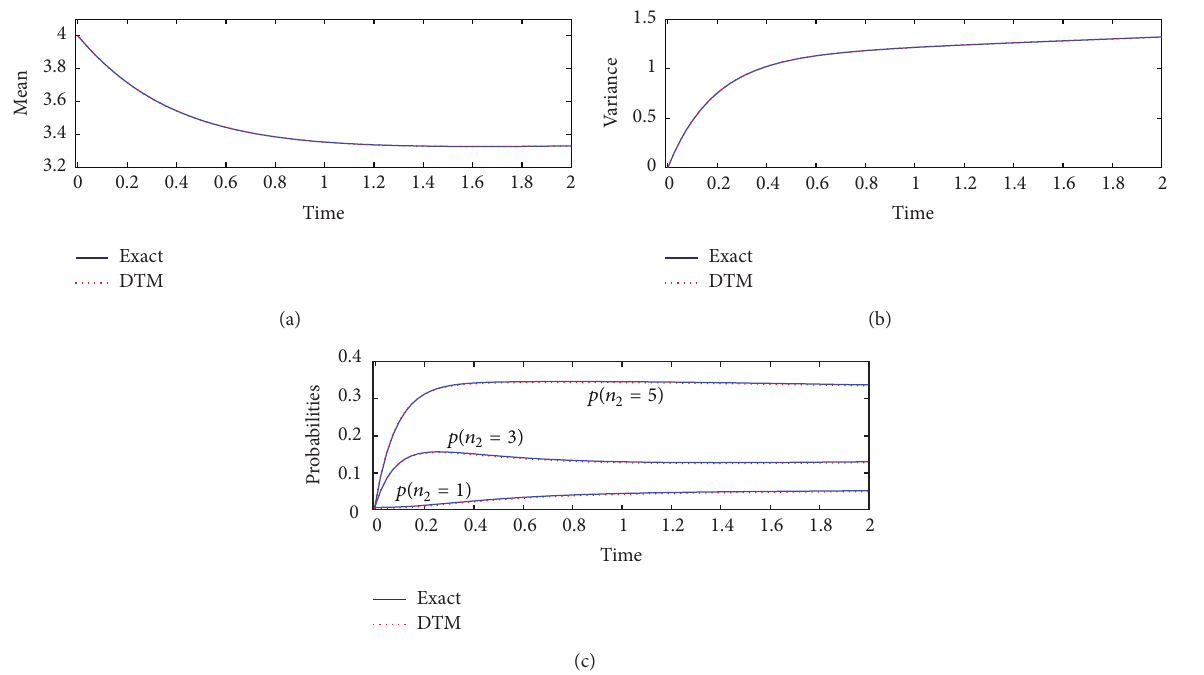
Figure 4: The initial condition 𝑛 = [5,4,2,3,2,3,2,0,0,0] and parameters 𝑐 1 = 𝑐 4 = 𝑐 7 = 𝑐 10 = 0.2 , 𝑐 2 = 𝑐 5 = 𝑐 8 = 𝑐 11 = 1 , and 𝑐 3 = 𝑐 6 = 𝑐 9 = = 0.1 are assumed. In (c), each curve 𝑝(𝑛 𝑐 12 terms which have a coefficient less than 10 −8 are dropped